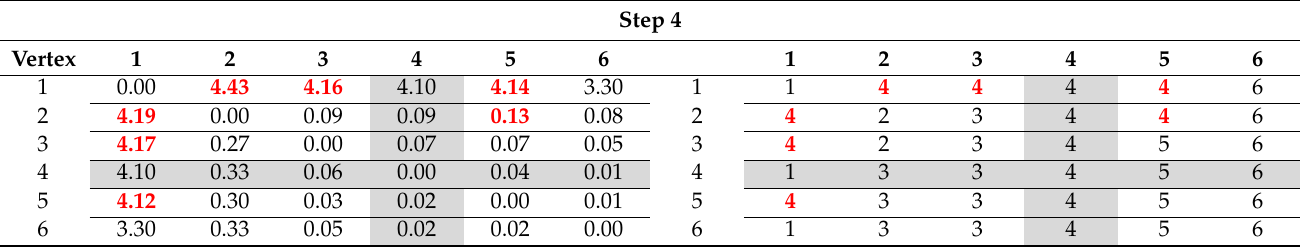
Table A13. The step 4 graphical process of the best search and rescue route.